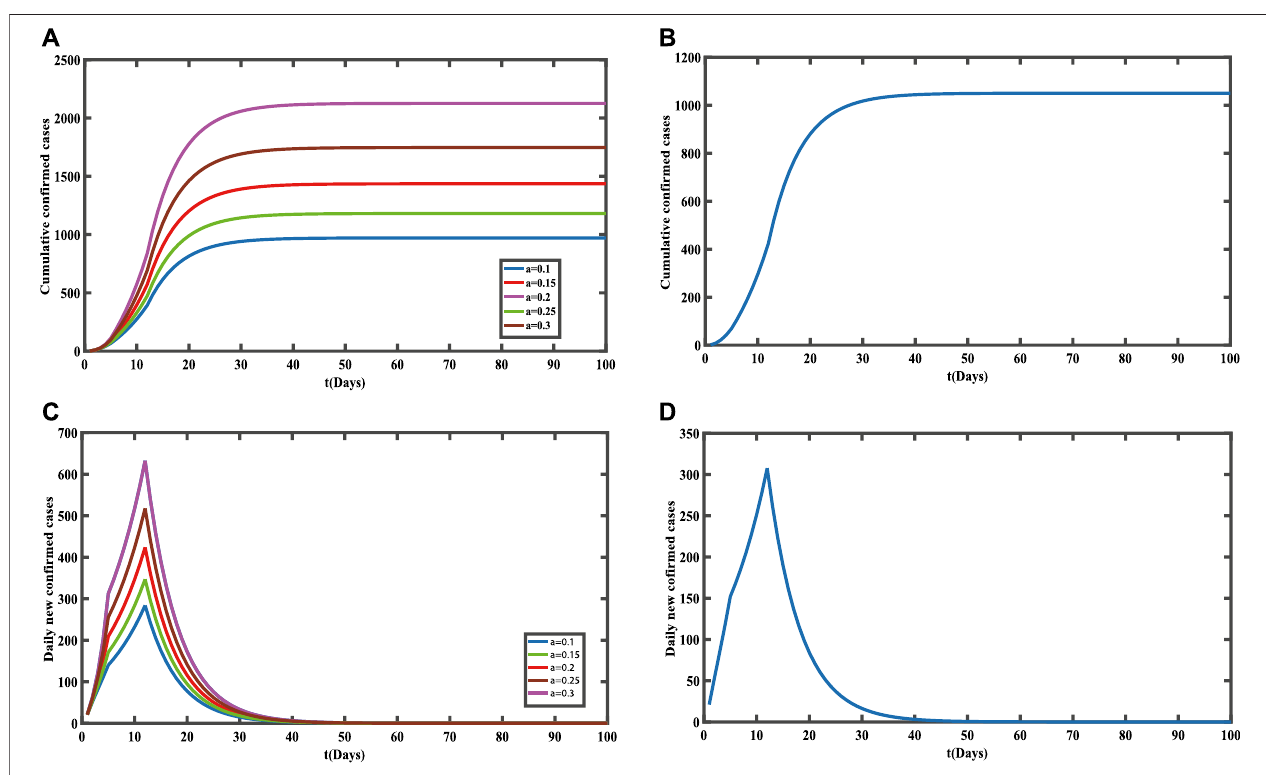
FIGURE7| In fl uenceofpopulationmigrationonCOVVID-19casesinHunanProvincebeforeandaftertheSpringFestival. (A) Cumulativecon fi rmedcasesbeforetheSpring Festival. (B) Cumulativecon fi rmedcasesaftertheSpringFestival. (C) Dailynewcon fi rmedcasesbeforetheSpringFestival. (D) Dailynewcon fi rmedcasesaftertheSpringFestival.